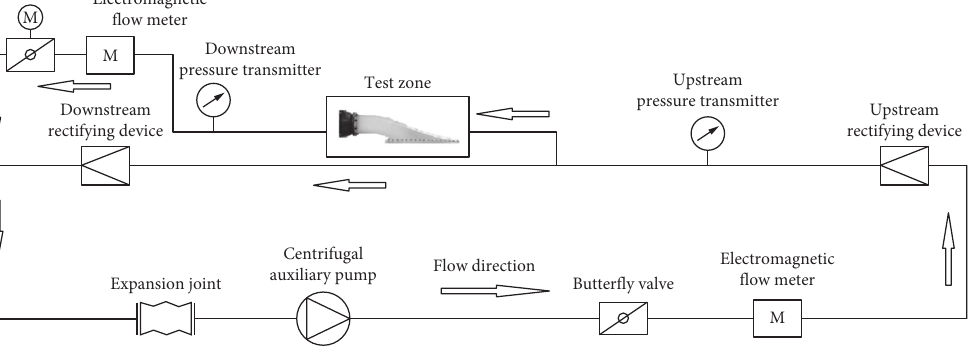
Figure 3: Waterjet propulsion device test system.